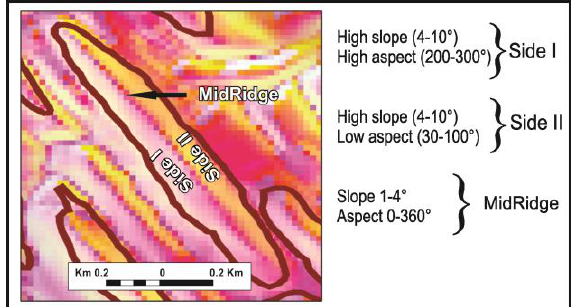
Figure 4. Merged values of elevation (red channel), slope (green channel) and aspect (blue channel) for A. Terrestrial drumlins